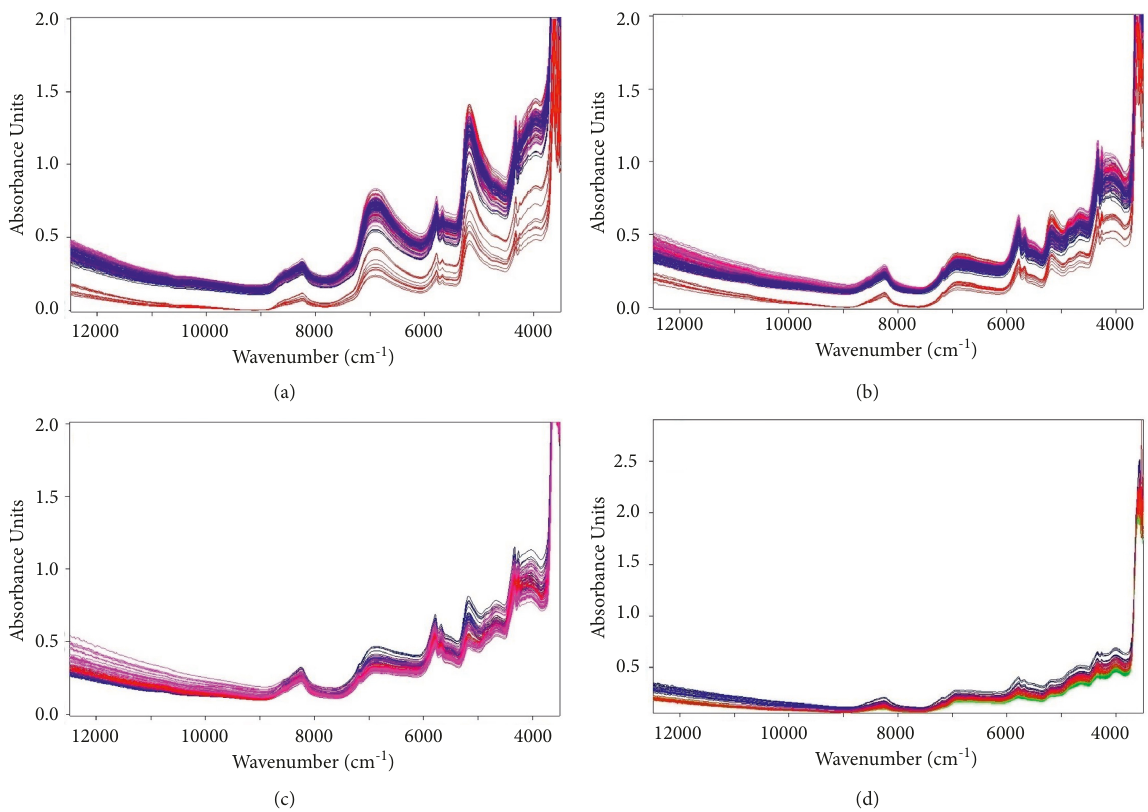
Figure 1: Absorption spectrum of (a) RC, (b) DU, (c) DF, and (d) DFD, in the range of 3600 to 12500cm − 1